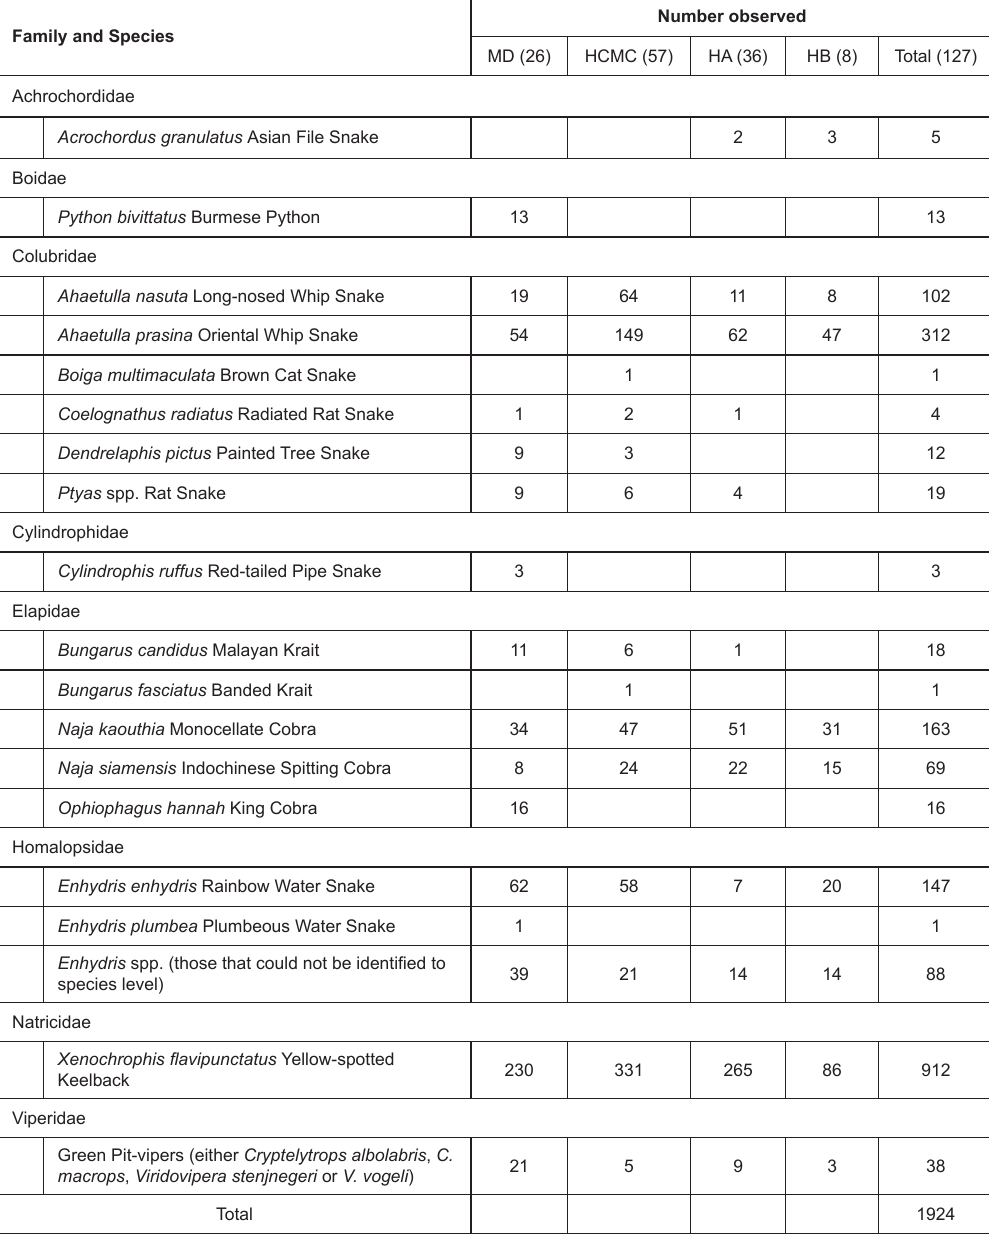
Table 1. Snake species and numbers used in snake wine in September 2009 at 127 locations in Mekong Delta (MD), Ho Chi Minh City (HCMC), Hanoi (HA) and Halong Bay (HB) in Vietnam. The number of locations visited in each area is given within